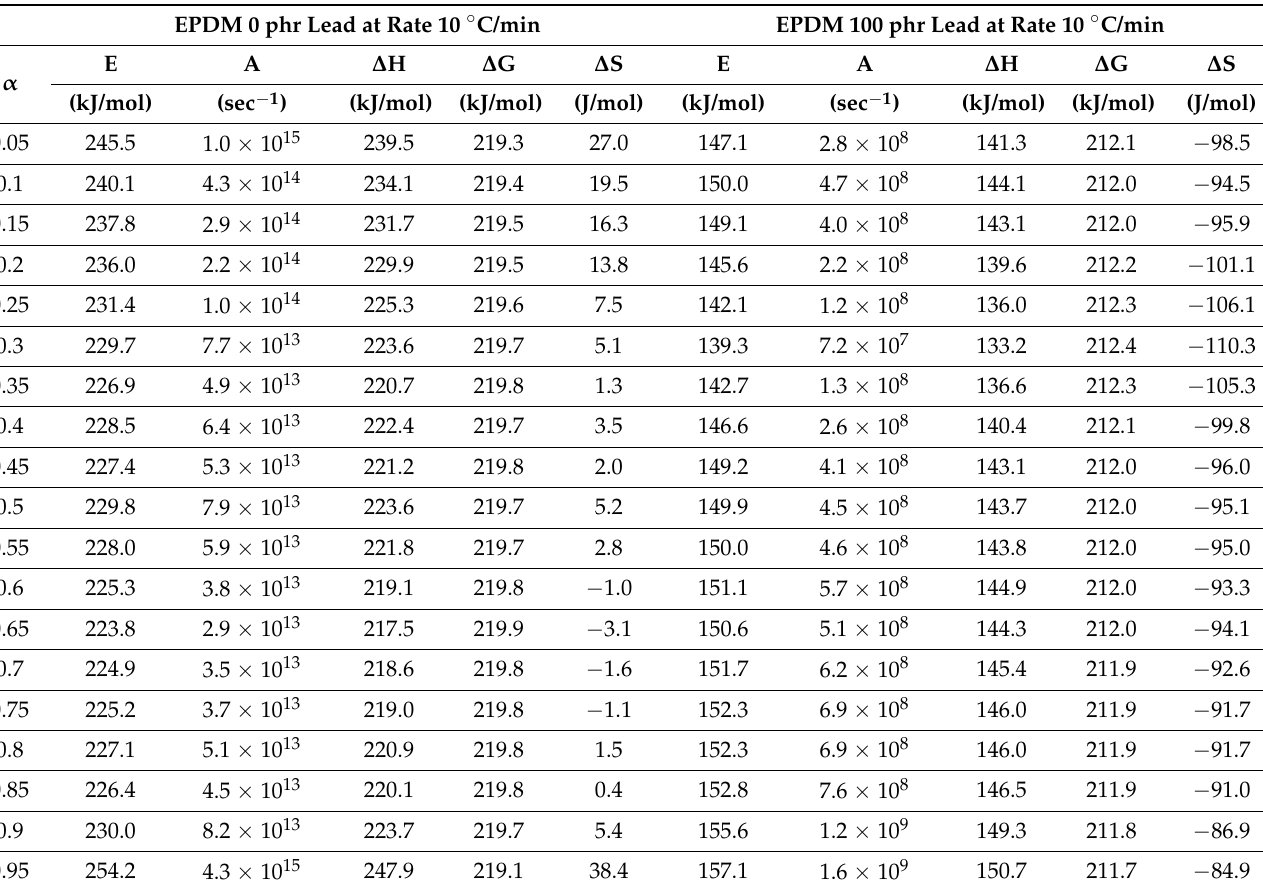
Table 9. The activation energy, pre-exponential factor, and thermodynamic parameters